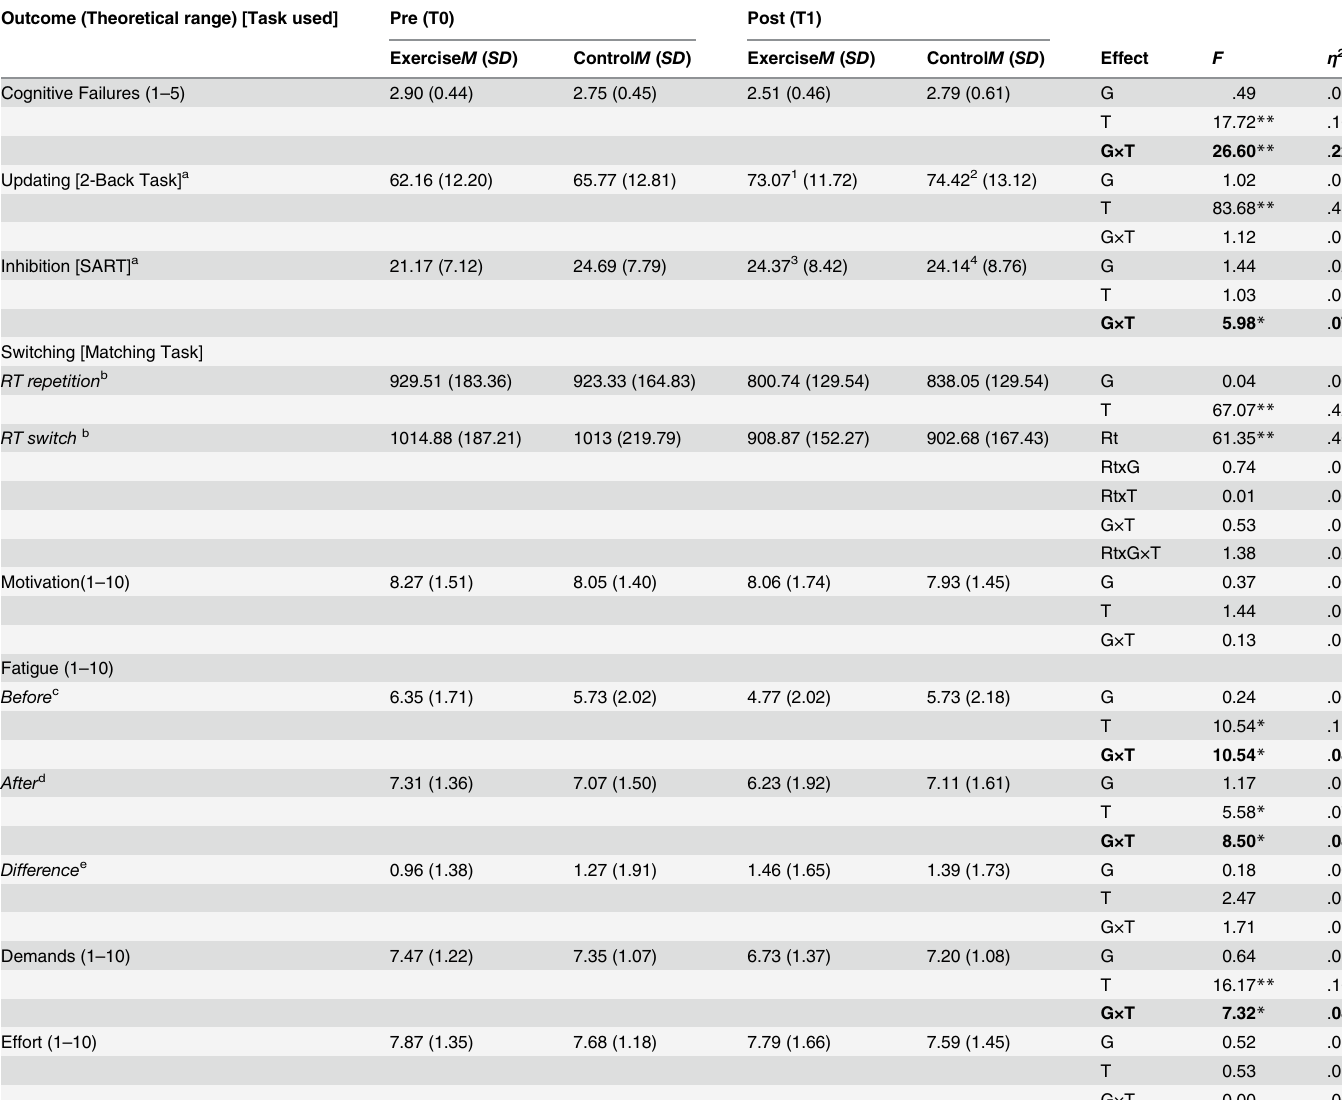
Table 4. Results for cognitive functioning pre (T0) and post intervention (T1) per